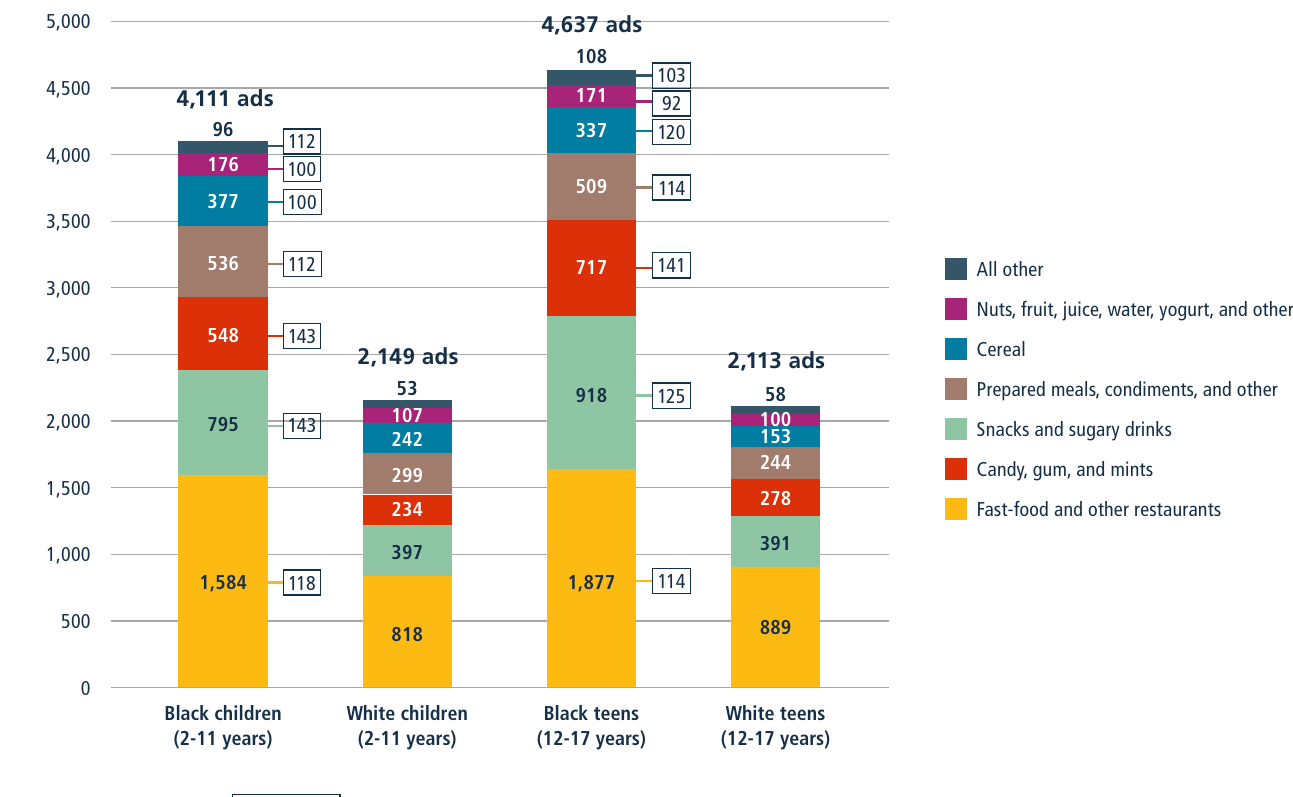
* Targeted indices are listed in the callout boxes. A targeted index greater than 100 indicates that Black children/teens were more likely to see TV ads for a specific product category compared to White children/teens controlling for differences in TV